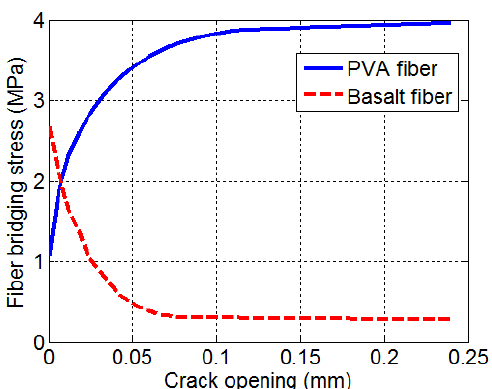
Figure 5. Predicted fiber-bridging curves.